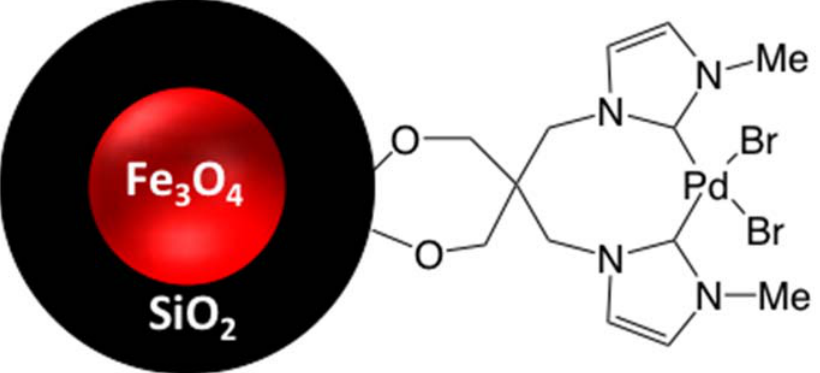
Figure 14. Bis( N ‐ heterocyclic carbene) palladium complex supported on silica coated magnetic Figure 14. Bis( N -heterocyclic carbene) palladium complex supported on silica coated magnetic nanoparticles [69] (Adapted with permission from John Wiley and Sons). nanoparticles [69] (Adapted with permission from John Wiley and Sons).